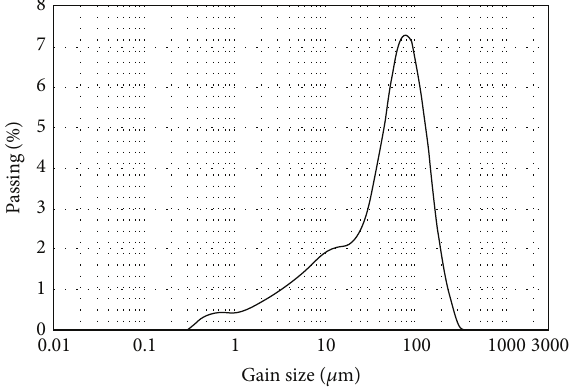
Figure 2: Particle size distribution of